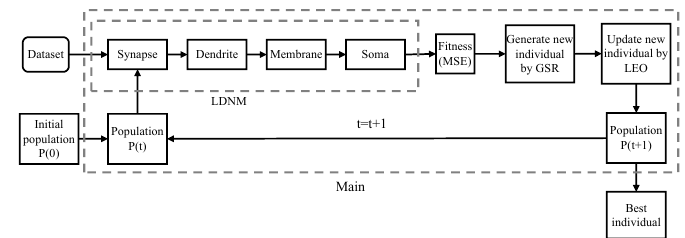
Figure 4. Flowchart of LDNM training using the GBO